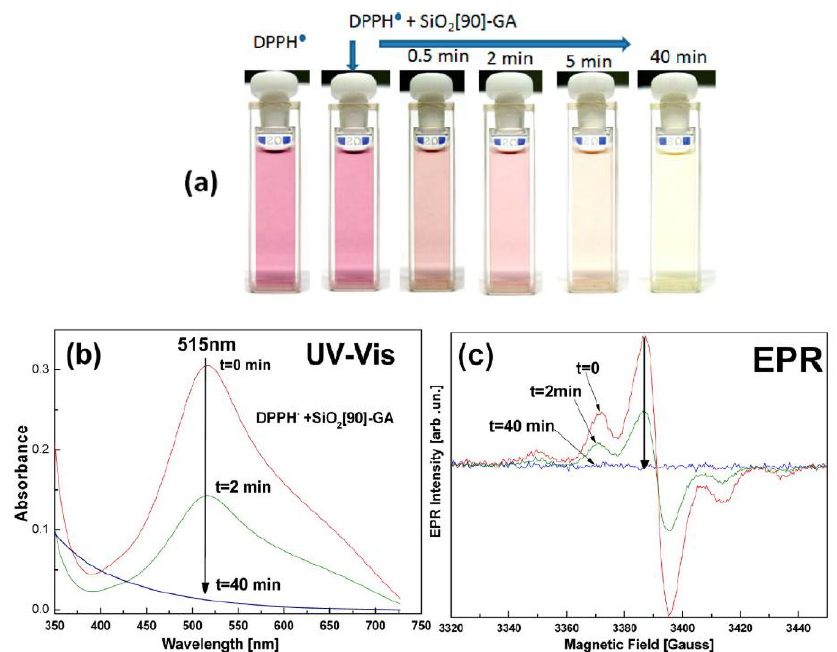
Figure 11. UV–Vis ( b ) and EPR ( c ) spectroscopic analysis of the DPPH radical scavenging by nanoantioxidants. The absorption from the visible region disappears ( b ), and the color of the solution changes from purple to pale yellow ( a ). Reprinted (adapted) with permission from [88]. Copyright 2023 American Chemical